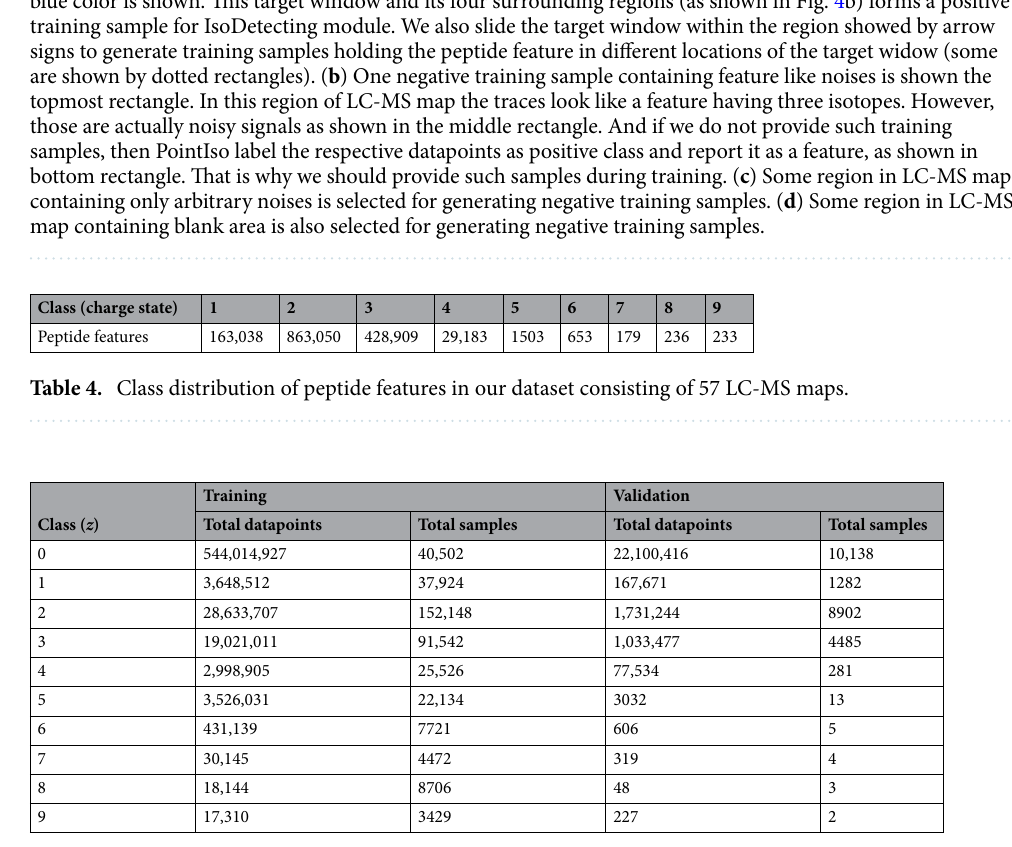
Table 5. Amount of samples for training and validation. Because of inadequate training data for features with charge states 5–9 as mentioned in Table 4, we had to apply data oversampling and augmentation to increase training samples from these classes. The amount of samples from class 0 depends on our choice. We chose the amount so that the total number of datapoints from this class is higher than others because the LC-MS map is very sparse. The validation set does not contain any duplicated data, and there is no overlapping between the validation dataset and the training